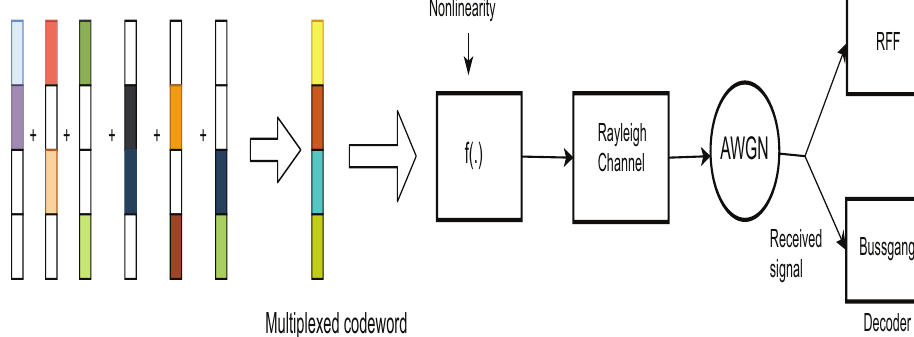
Figure 1. Depiction of the System Model for SCMA.